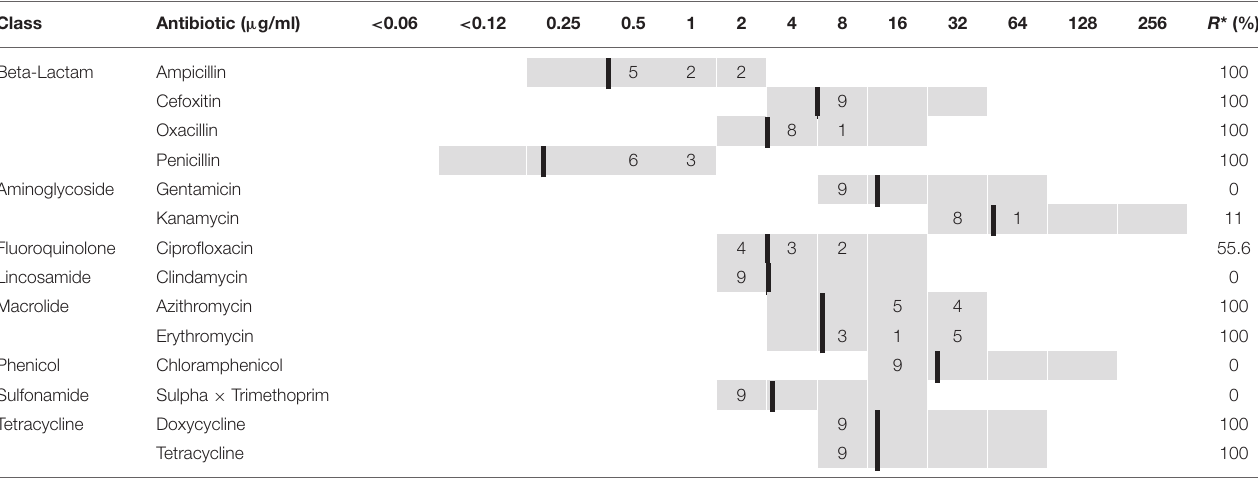
( Table 2 ). The resistance rates for azithromycin,